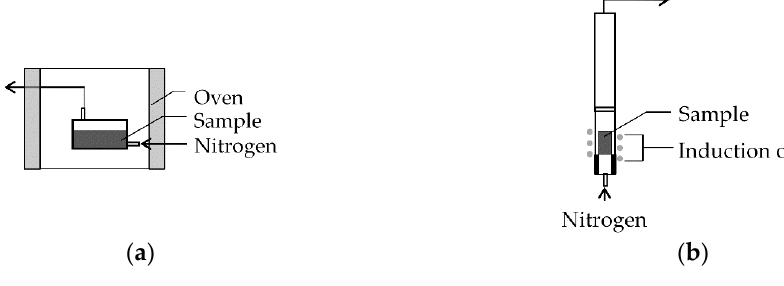
Figure 1. ( a ) Device M used for pyrolysis ; ( b ) Device P used for pyrolysis .